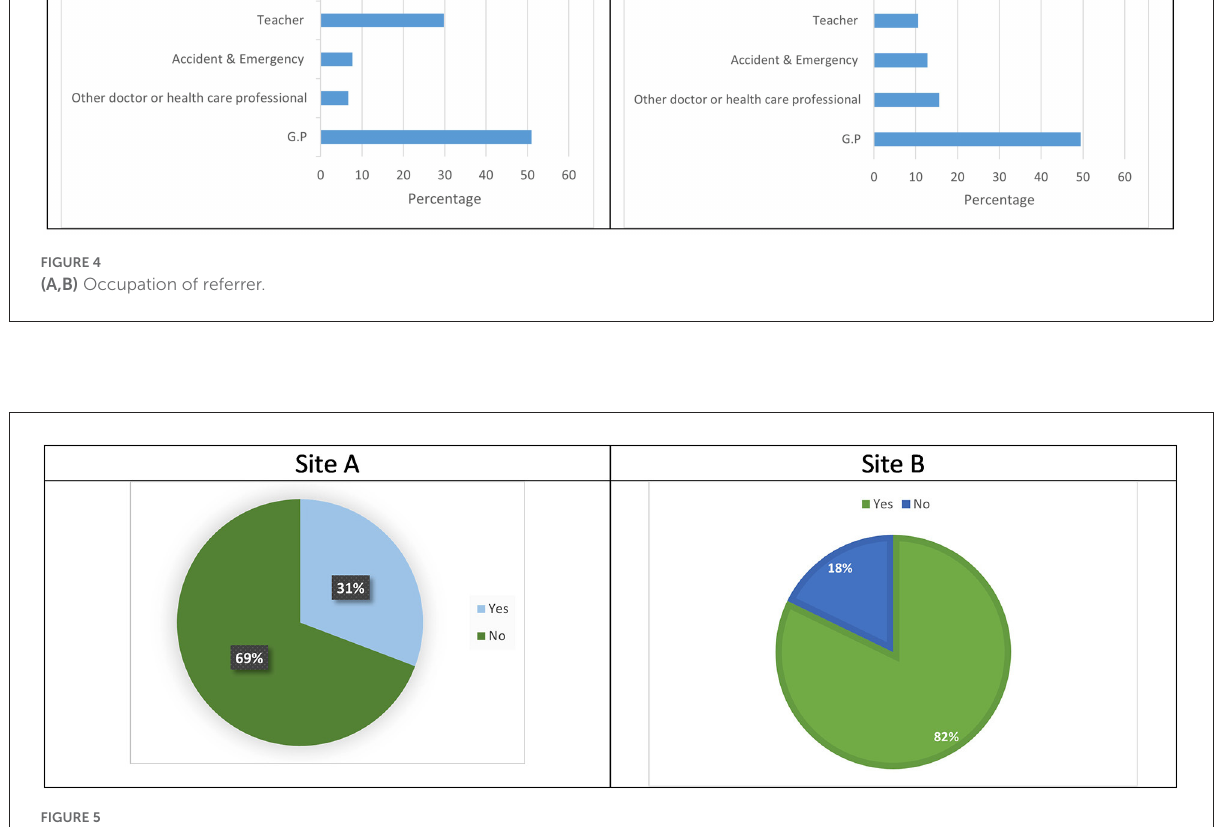
FIGURE5 (A,B) Offered an assessment.